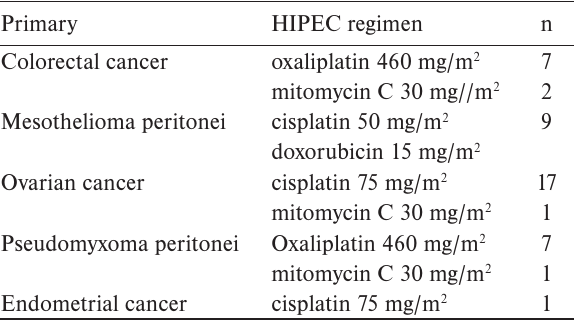
Table 2. HIPEC regimens used in COC